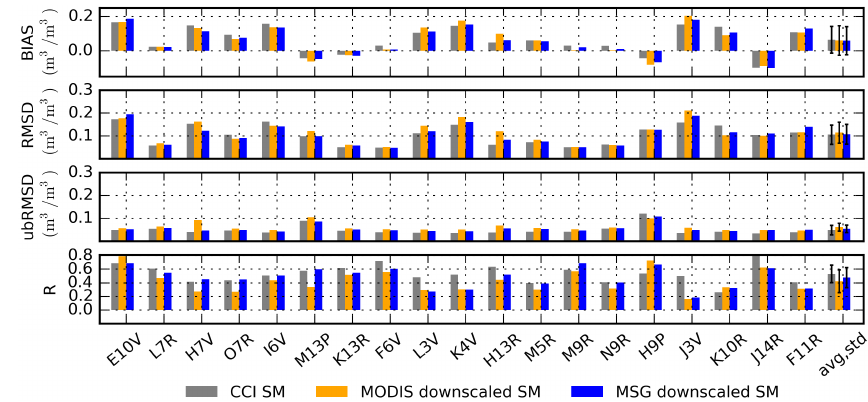
Figure 6. Bar plots for the comparisons between CCI soil moisture, downscaled soil moisture, and in situ soil moisture at each station.